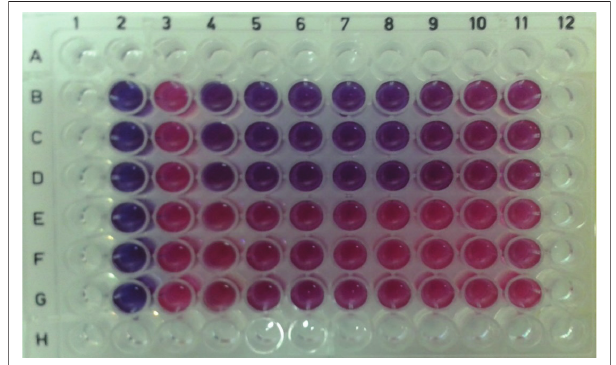
FIGURE 2-A1: Plate A.2 – Susceptibility effect of rifampicin and weak inhibitory effect of Ethambutol on Mycobacterium tuberculosis on a 96-well microtitre plate: Well A1-12; H1-12: Sterile water; well 2 (Control 1): 100 µ L medium and 100 µ L of 500 µ g/mL volatile oil; no Mycobacterium tuberculosis ; well 3 (Control 2): 100 µ L medium and 100 µ L Mycobacterium tuberculosis inoculums; well 4 (Control 3): 100 µ L medium containing 1 % absolute ethanol and 100 µ L Mycobacterium tuberculosis inoculum; wells 5–11: (250, 125, 67.5, 31.3, 15.6, 7.8, 3.9 µ g/mL); B, C, D: oil from solvent-free microwaved essential and E, F, G: oil from